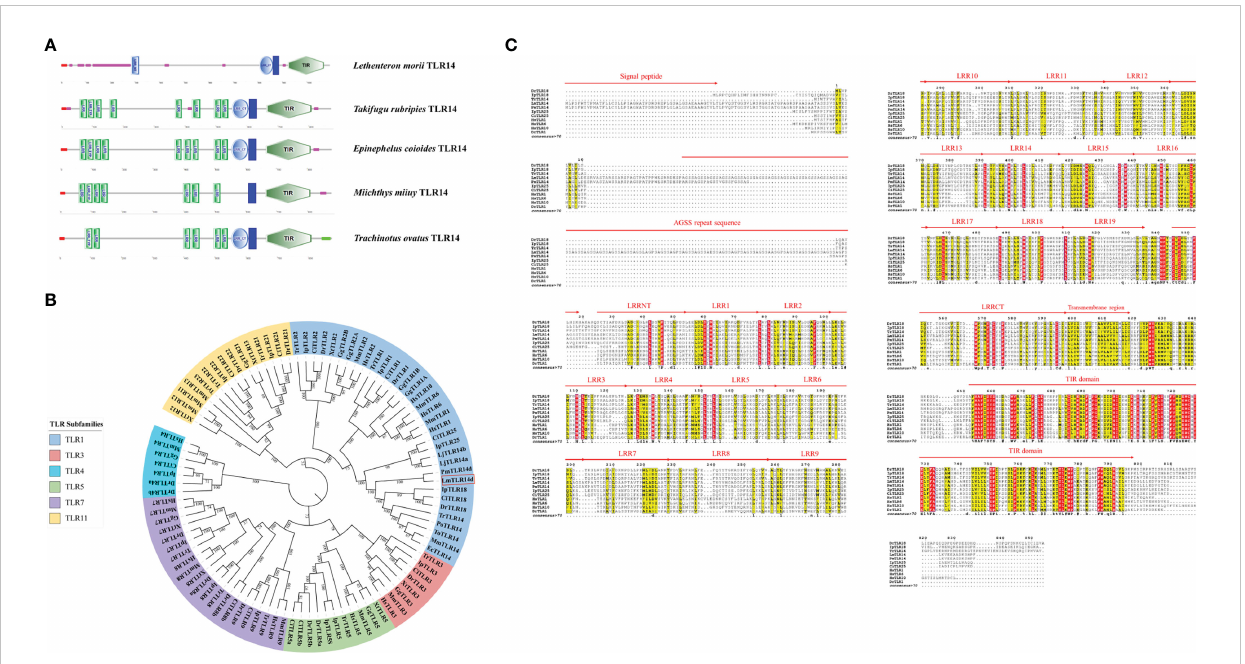
FIGURE 1 Preliminary domain analysis and homologous relationship of LmTLR14d. (A) TLR14 domain features predicted by SMART online software. (B) Phylogenetic tree constructed based on LmTLR14d amino acid with Neighbor-joining method. A bootstrap analysis is performed using